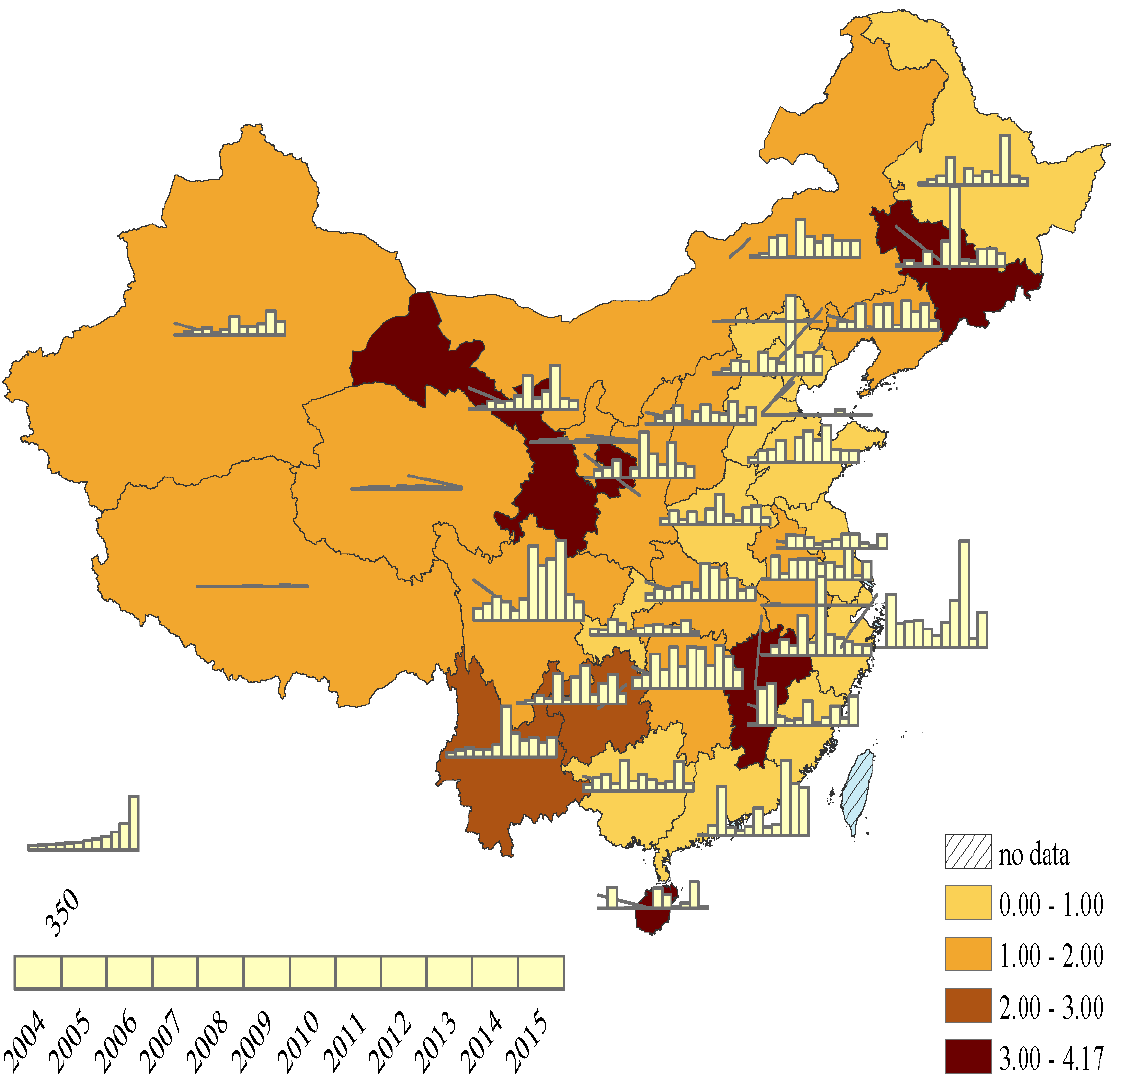
Figure 6. Direct economic losses (100,000,000) and mean loss rate of GDP (%) caused by meteorological disasters at provincial level, 2004–2015. The bar charts correspond to direct economic losses while the color map corresponds to mean loss rate of GDP (%). Note. ArcGIS 10.2